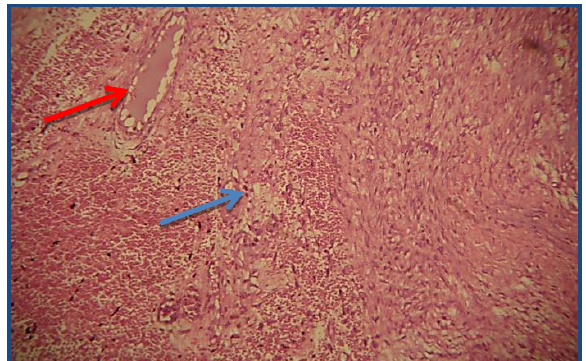
Figure (6): Stomach of rabbit (G1), at 7th day p.o showing sever hemorrhage (blue arrow) and presence of serum protein in the lumina of blood vessels (red arrow) (H and E 20X).